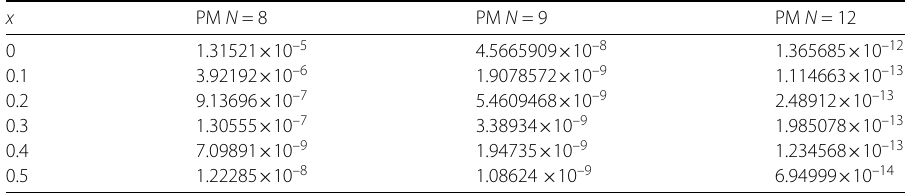
Table 7 Comparison of the absolute errors for Example 5 for different N values at ν 4 = 4